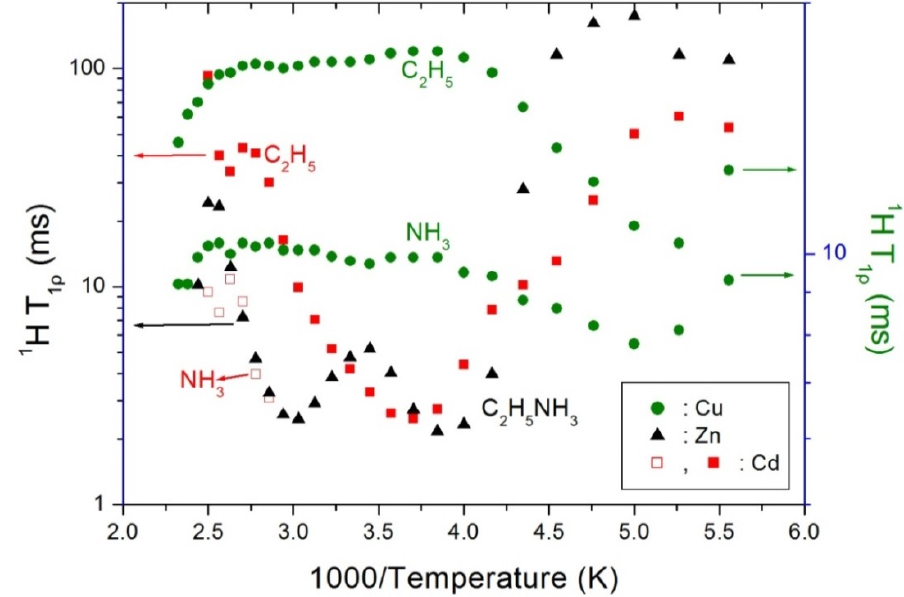
Figure 5. 1 H spin-lattice relaxation times T 1 ρ in the rotating frame in (C 2 H 5 NH 3 ) 2 M Cl 4 ( M = Cu, Zn, and Cd) as a function of inverse temperature.